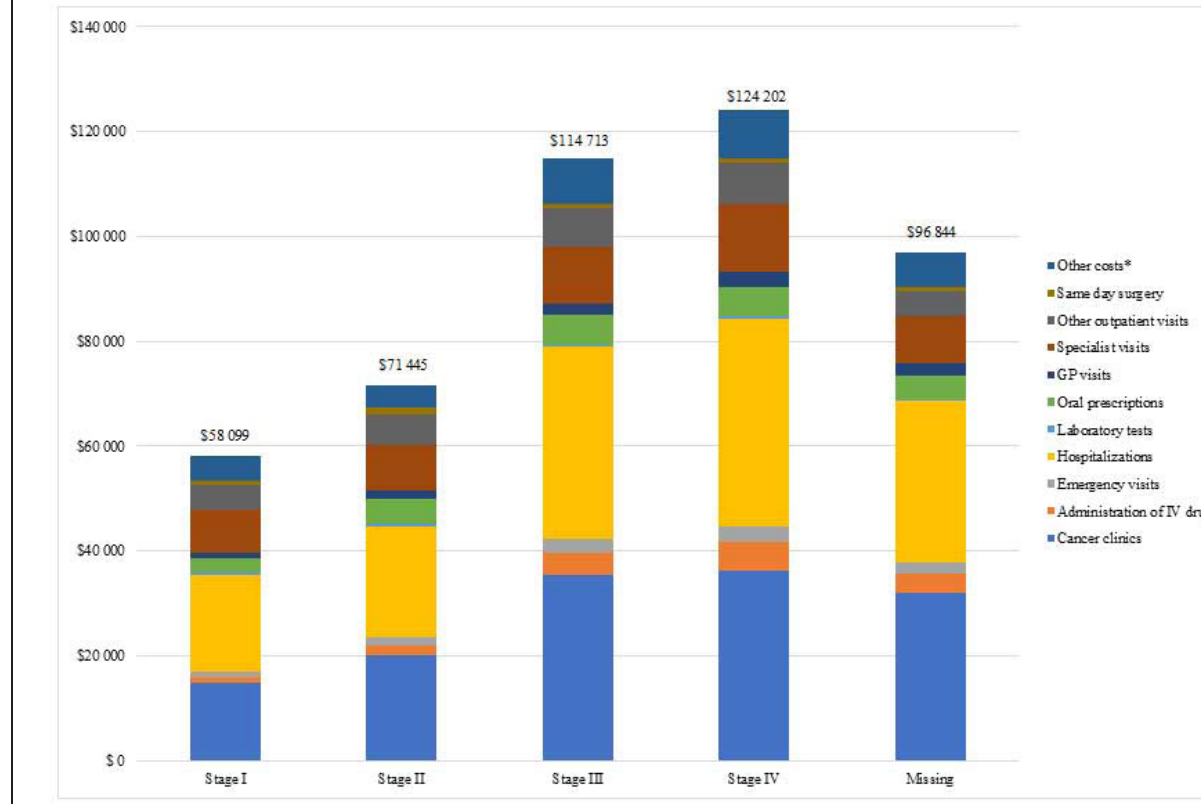
Figure 4. Mean Cost per Patient, Stratified by Stage of